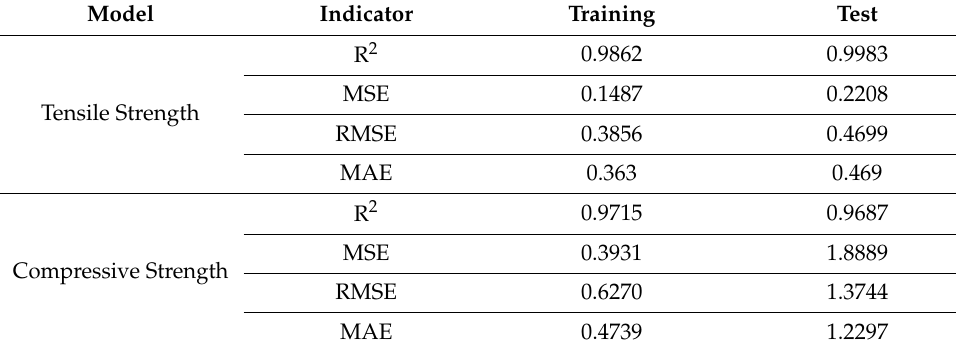
Table 12. Performance criteria for training and test phases. Model